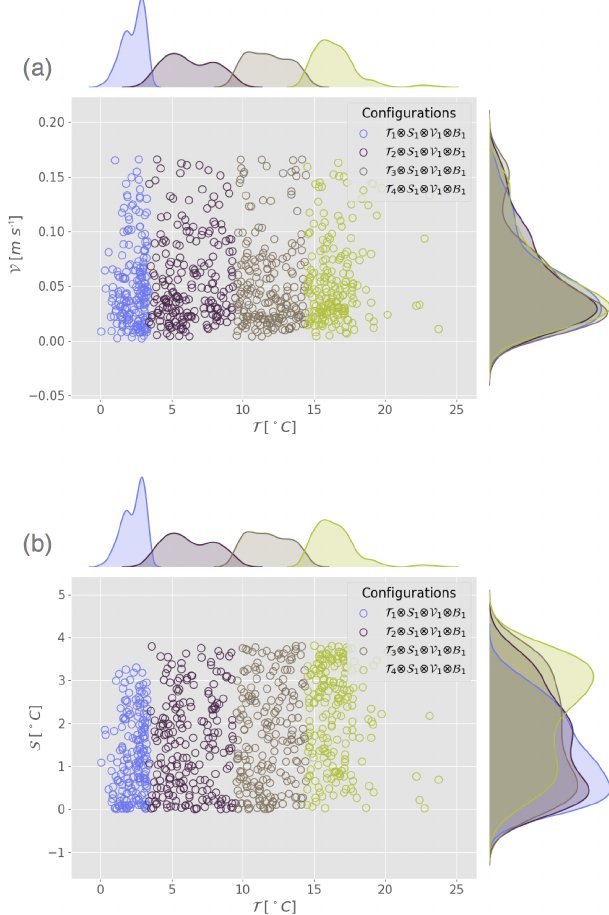
Figure 5. Scatter plot and marginal distribution from kernel density estimation in the plane (a) ( T , V ) and (b) ( T , S ) for the configura- tions corresponding to Exp. 3a, b, c and d from Table